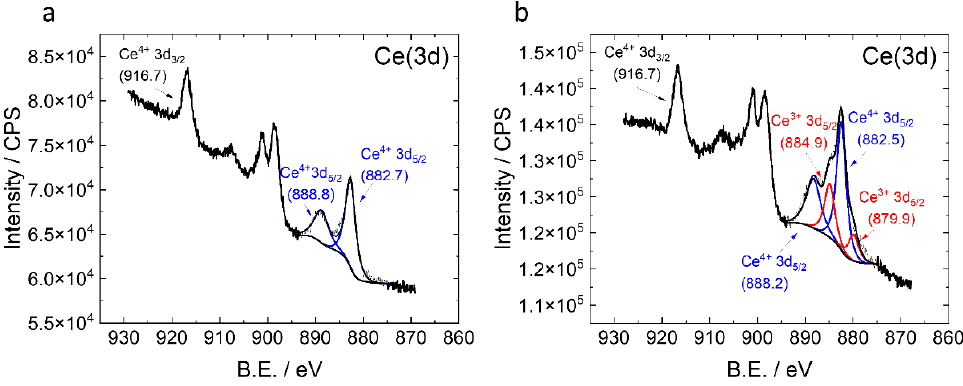
Figure 5. XPS narrow scan regions of the Ce(3d) after CV ( a ) and pristine WE condition ( b ).